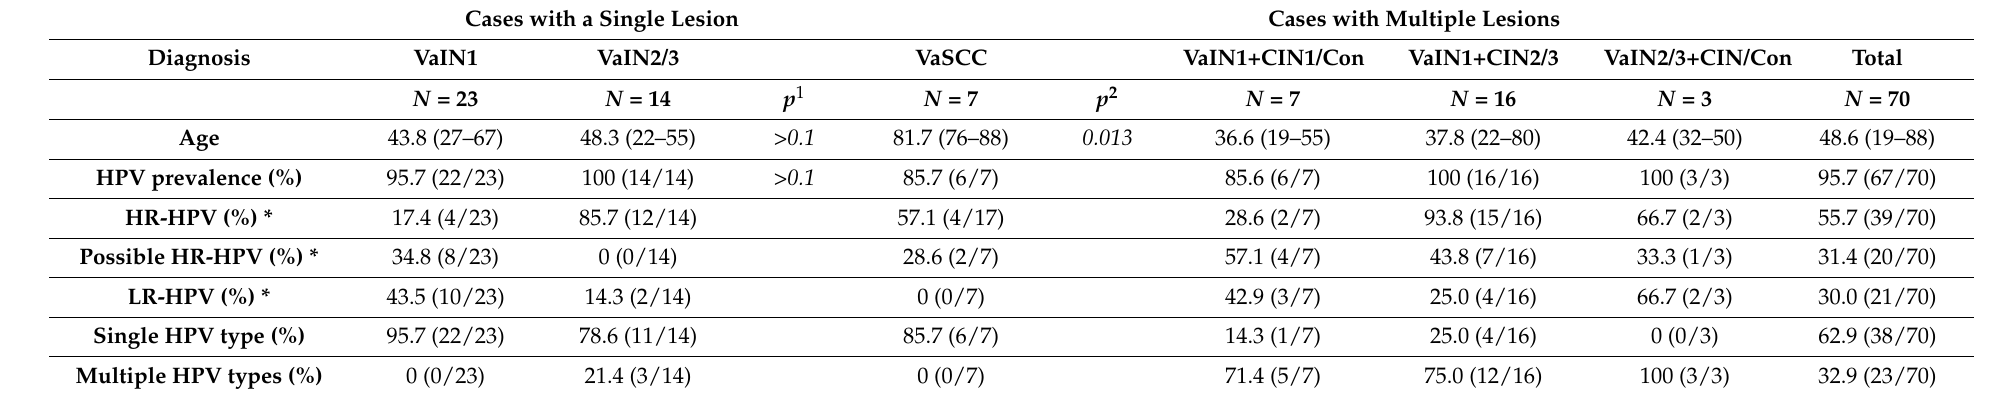
Table 1. Age of patients, histological diagnosis and HPV infection by E6/E7 PCR using tissue specimens. Cases with a Single Lesion